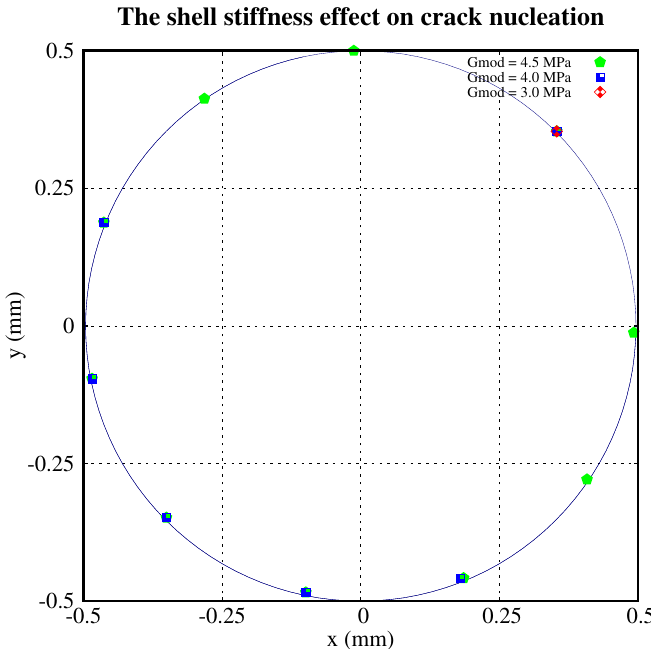
Figure 6. Crack nucleations with different stiffnesses of the shell.